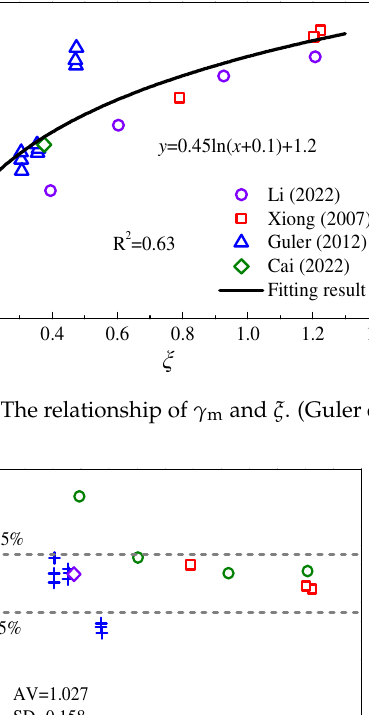
errors were almost within the range of 15%.